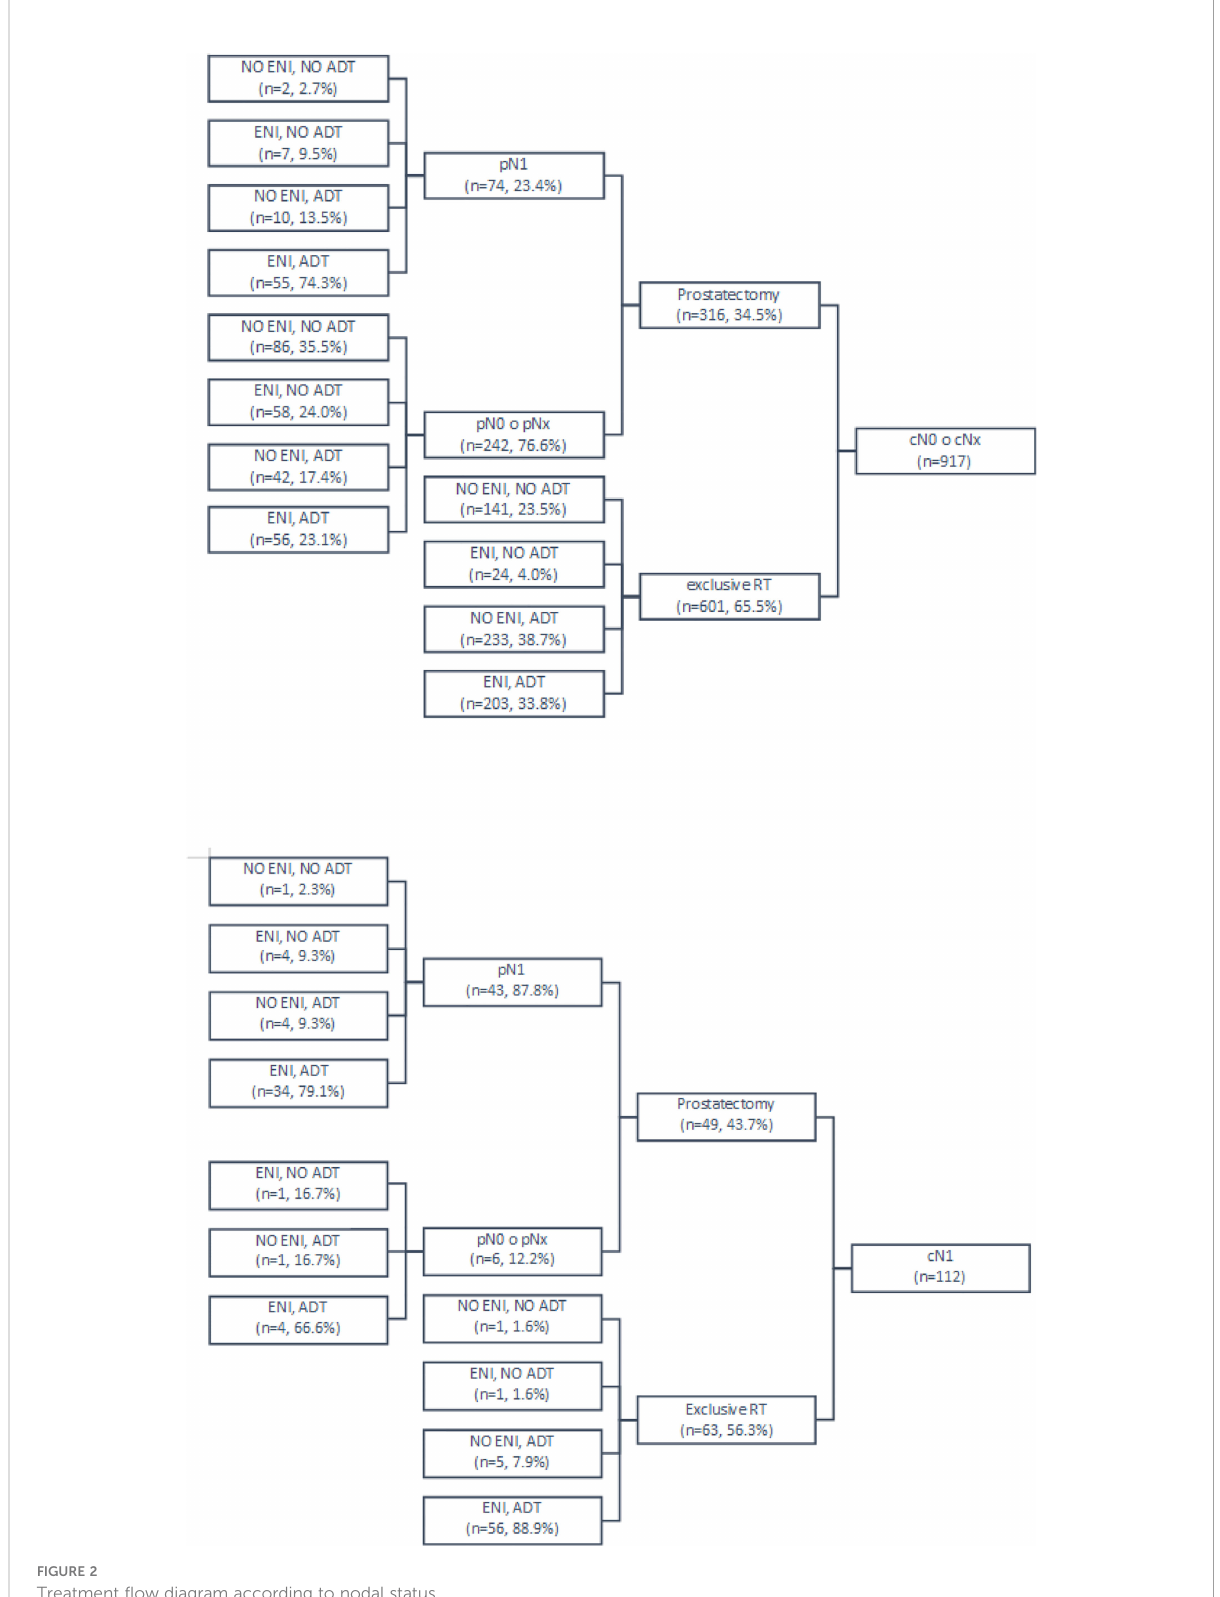
FIGURE 2 Treatment fl ow diagram according to nodal